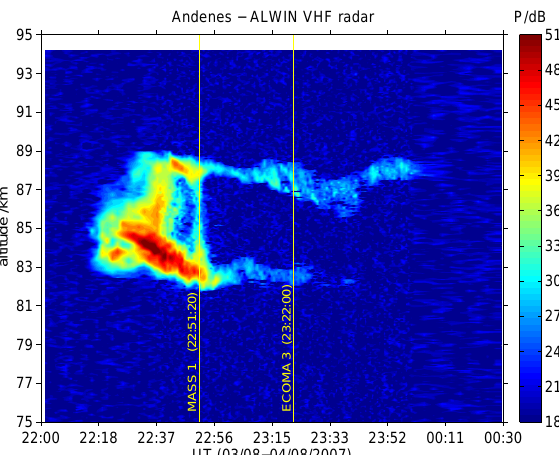
Fig. 2. Power values (colour coded) observed with the ALWIN VHF-Radar as a function of altitude and time on 3 August 2007. The two vertical yellow lines indicate the times of the MASS and ECOMA-03 rocket launches at 22:52UT and 23:22UT, respec-